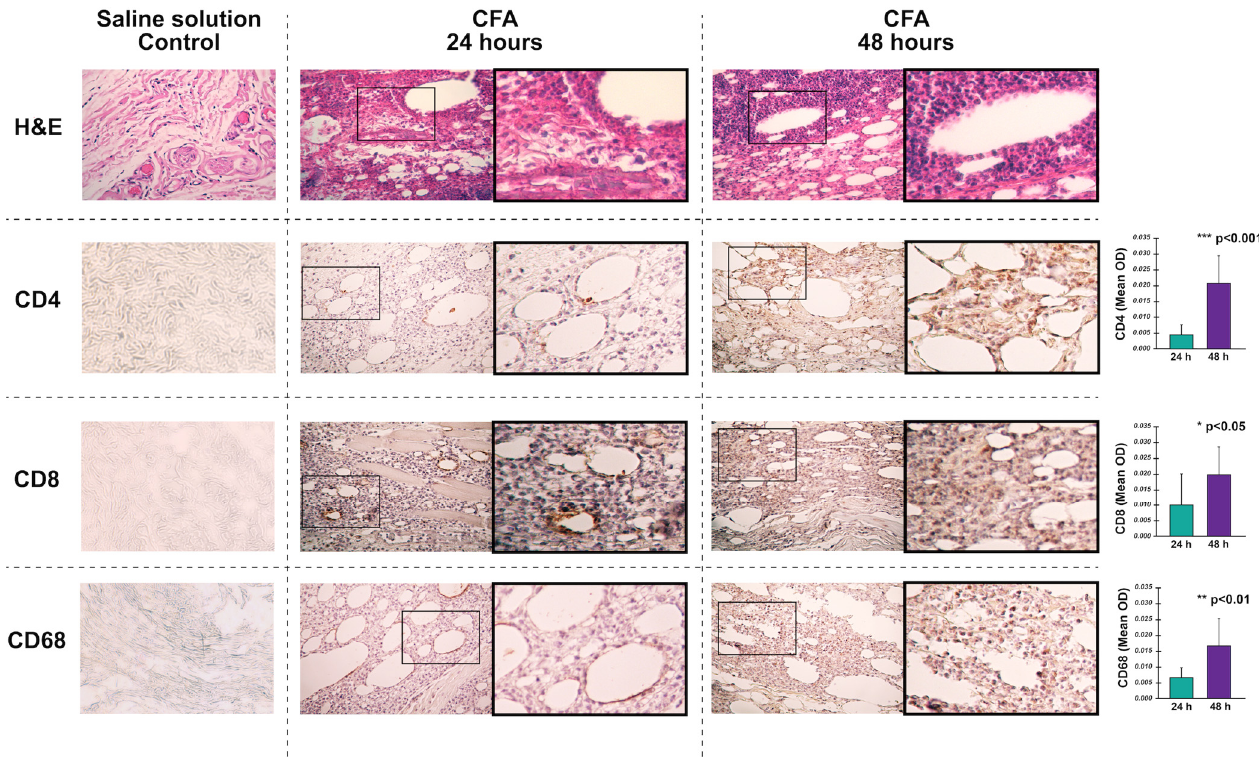
Figure 4. Histological analysis of the rats’ footpads in very early stages of adjuvant-induced arthritis. Inflammatory infiltrates in footpads after injecting a saline solution and Complete Freund’s Adjuvant (CFA) at 24 and 48 h through hematoxylin and eosin (H&E) stains are shown in Row 1. Immunodetection of CD4, CD8, and CD68 in CFA-injected footpads at 24 and 48 h are shown in Rows 2, 3, and 4, respectively. CD4, CD8, and CD68 expressions were quantified with the ImageJ program and the IHC toolbox. The DAB color was extracted from each image, and the maximum and mean gray values were obtained. Each image’s optical density (OD) was obtained with log10(maximum gray value/mean gray value). The OD means and standard deviations were calculated and graphed. Student’s t -test was used to compare the expression at 24 h and 48 h.